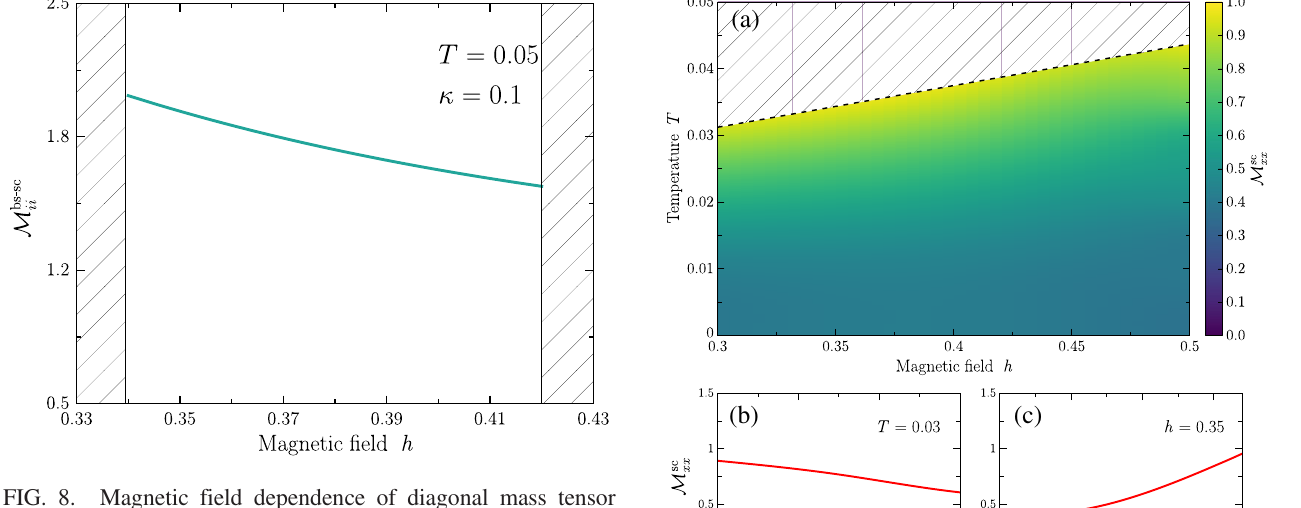
for a fixed xx xx